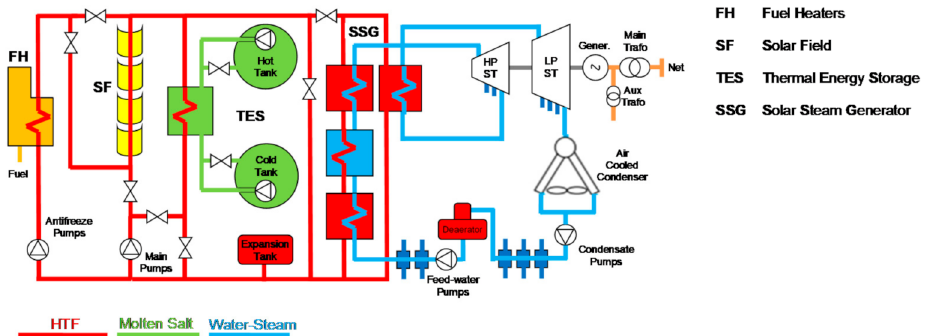
Figure 2. Generic parabolic trough layout.